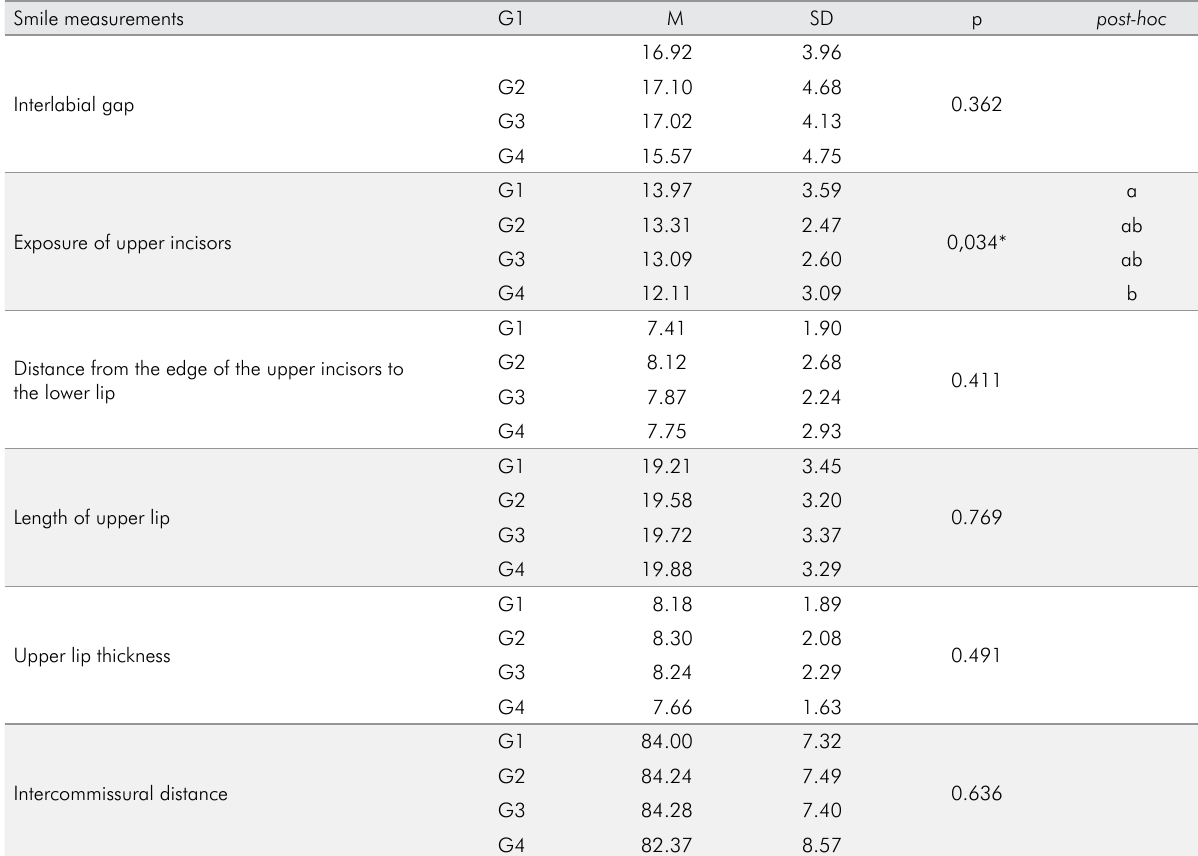
Table 3. Measurement results obtained by age group on smiling - Mean (M), Standard Deviation (SD), p-value (p). Smile measurements